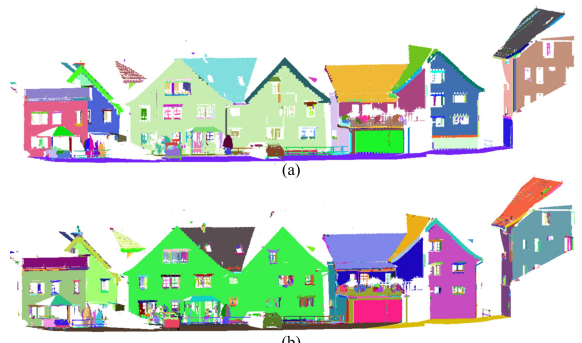
Figure 7. Segmentation of building facade using (a) VGS and (b) SVGS methods.